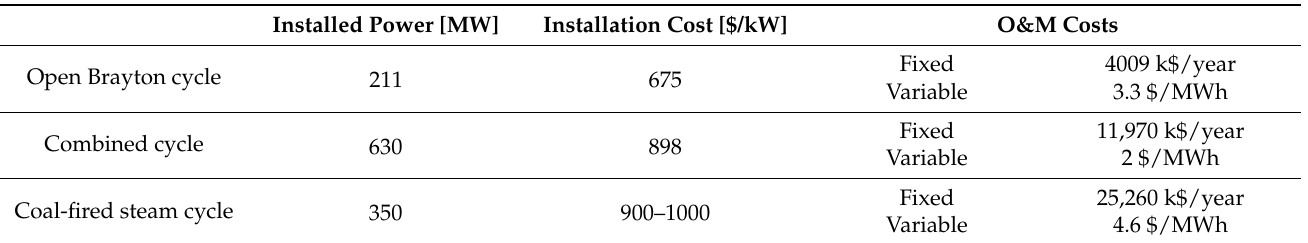
Table 3. Installation, operation and maintenance costs of different power cycles (data source: [24,102, 103,105,107–109]).